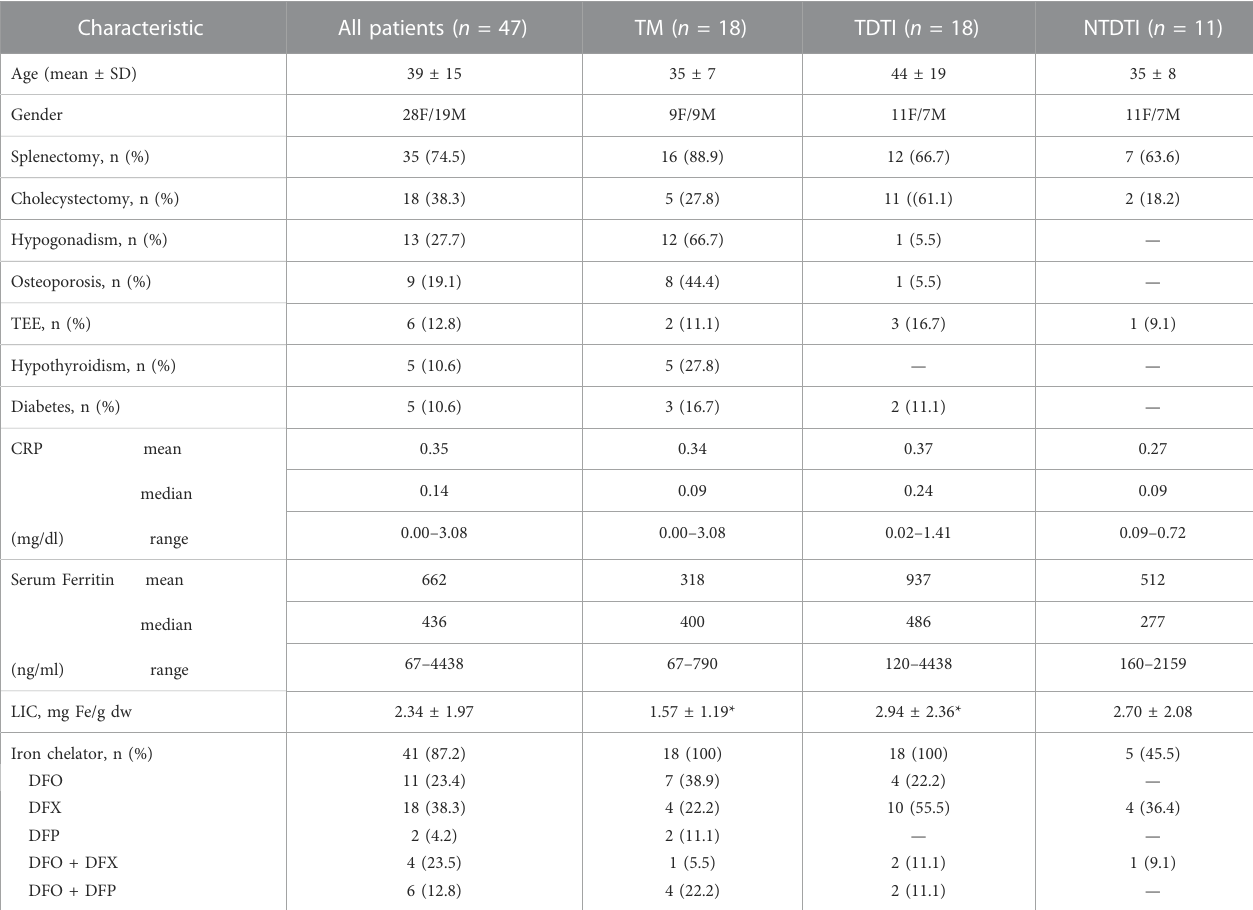
TABLE 1 Patients, disease, and treatment characteristics.